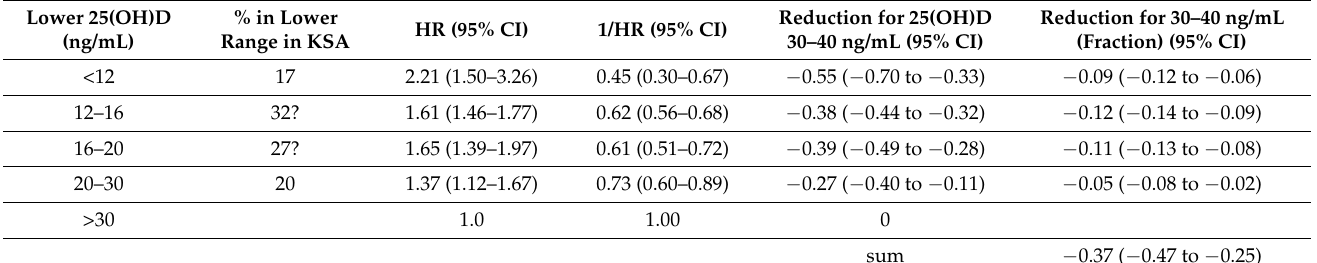
Table 7. Estimate of reduction in CVD mortality rate in the KSA by raising minimum 25(OH)D concentration to 30 ng/mL using 25(OH)D data from [86] and results from northern Europe